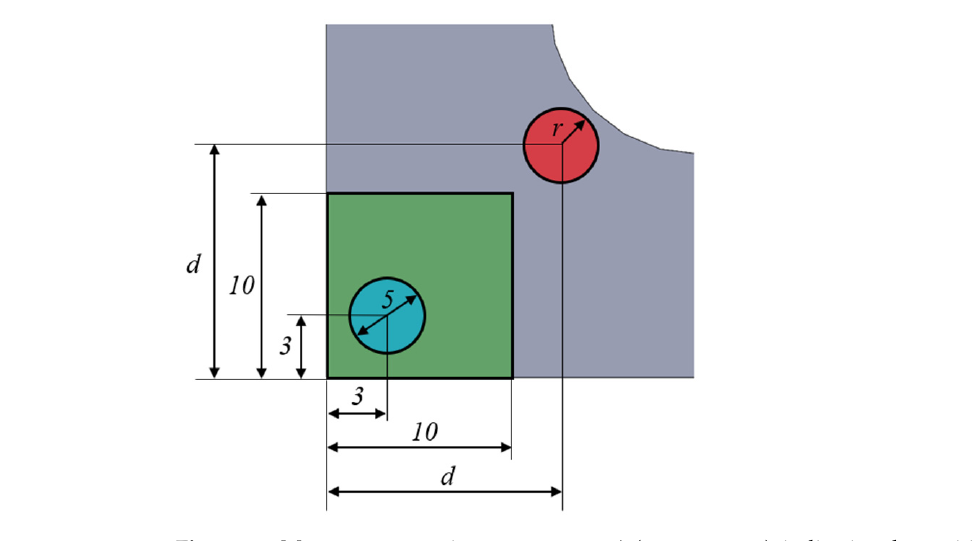
Figure 12. Measurement region on geometry A (green square), indicating the position and dimensions of the strain rosette (blue circle) and the opening (red circle). Units are in mm.